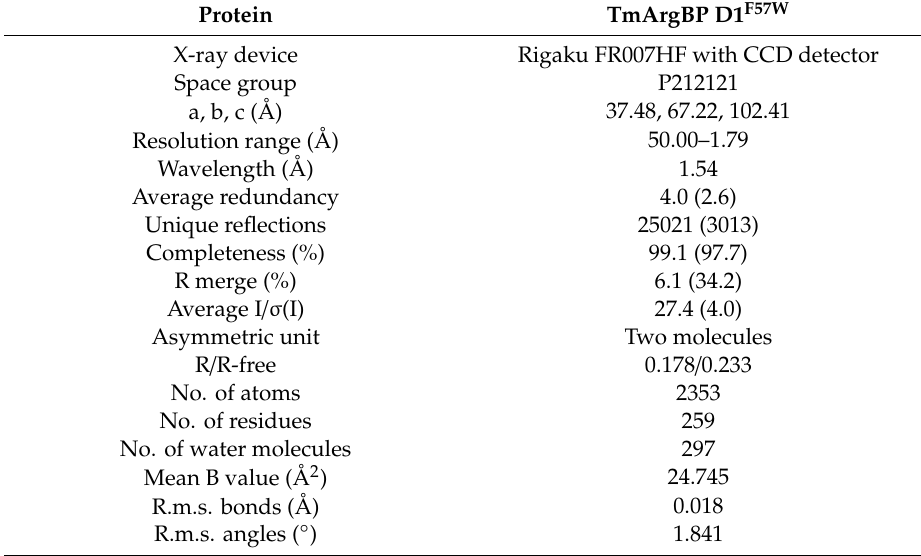
Figure 6. ( A ) E ff ect of the arginine binding on the Trp fluorescence of D1 F57W . The concentration of the protein was 45 µ M. ( B ) Maximum of the fluorescence intensity reported as function of the concentration. ( C ) Fluorescence measured on a D1 F57W sample that was initially saturated with arginine and then extensively washed. ( D ) Variation of the Trp fluorescence of D1 F57W upon GuHCl titration. Table 1. Data collection and refinement statistics of TmArgBP D1 F57W . Values in parentheses are for the highest-resolution shell (1.87–1.79